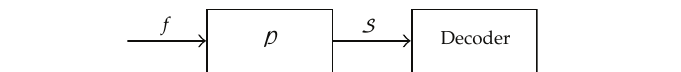
Figure 2: Bar code signal processing diagram. Signal processor P produces digital bar pattern S